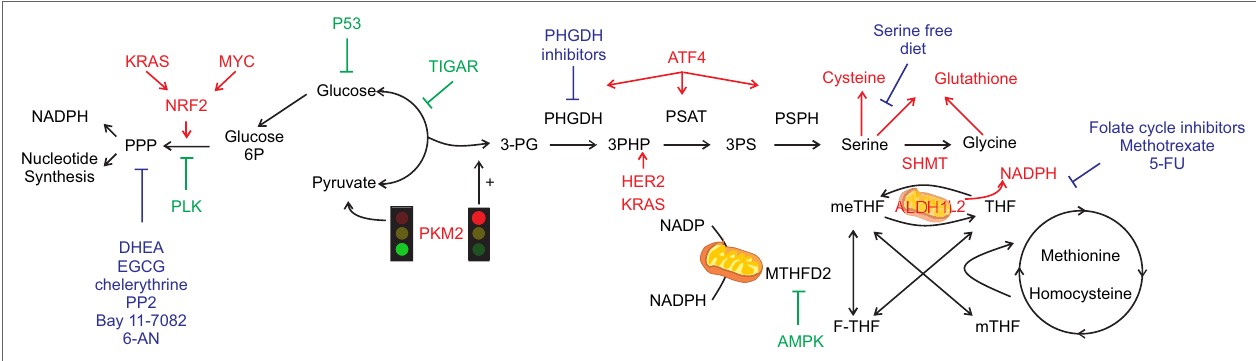
FiGURe 1 | One-carbon metabolism (1-CM) and pentose phosphate pathway (PPP) at the cross-road between anabolism and redox balance. Simplified scheme of the crosstalk between metabolic and signaling pathways that can occur in cancer cells. Pro-tumorigenic signals are represented in red and anti-tumorigenic in green. Glycolysis regulates both PPP and 1-CM. Serine signaling pathway, once PKM2 activity is inhibited (red light), leads to glycolytic intermediates accumulation hence fueling both PPP and 1-CM. Serine metabolism enzymes bridge the shunt between glycolysis and 1-CM, with specific oncogene upregulating the enzymes involved [i.e., phosphoglycerate dehydrogenase (PGHDH), phosphoserine aminotransferase 1 (PSAT1), phosphoserine phosphatase (PSPH)], leading to serine generation and antioxidant machinery intermediates (cysteine and glutathione). Serine hydroxymethyltransferase (SHMT) mediates the conversion between serine and glycine with the concurrent transformation of tetrahydrofolate (THF) into 5,10-methylenetetrahydrofolate (meTHF). Aldehyde dehydrogenase 1 family member (ALDH1L) mediates the opposite reaction with concurrent generation of NADPH, similarly methylenetetrahydrofolate dehydrogenase (MTHDF) transform meTHF into 10-formyltetrahydrofolate (F-THF) with concurrent generation of nicotinamide adenine dinucleotide phosphate. The main chemotherapy agents are represented in blue. Dehydroepiandrosterone (DHEA), epigallocatechin gallate (EGCG), amino-5-(4-chlorophenyl)-7-(t-butyl)pyrazolo[3,4-d]pyrimidine (PP2), 6-aminonicotinamide (6-AN), and 5-fluorouracil